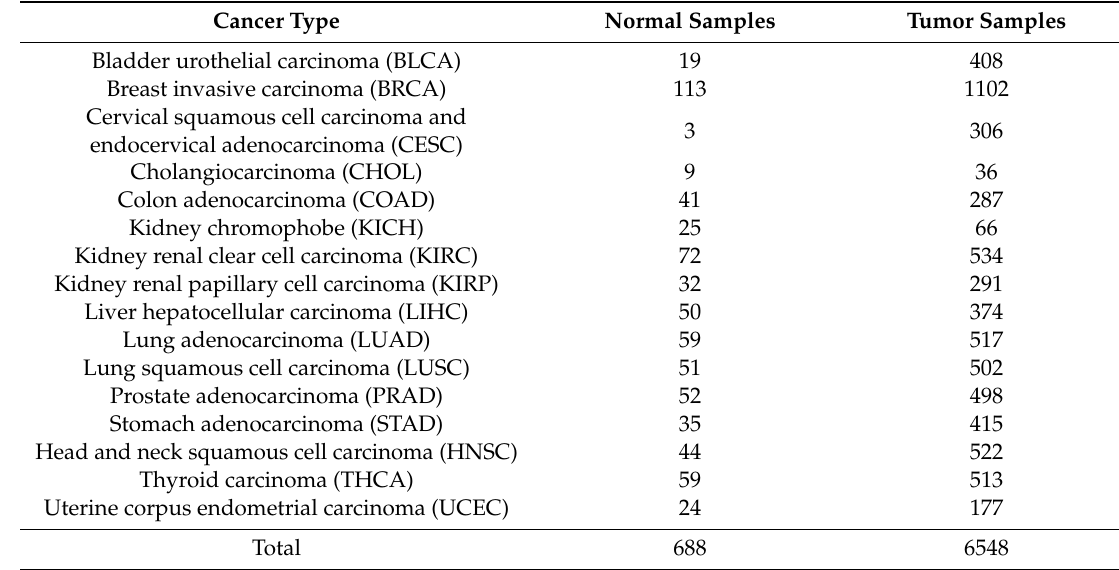
Table 1. Cancer types and the number of samples used from The Cancer Genome Atlas